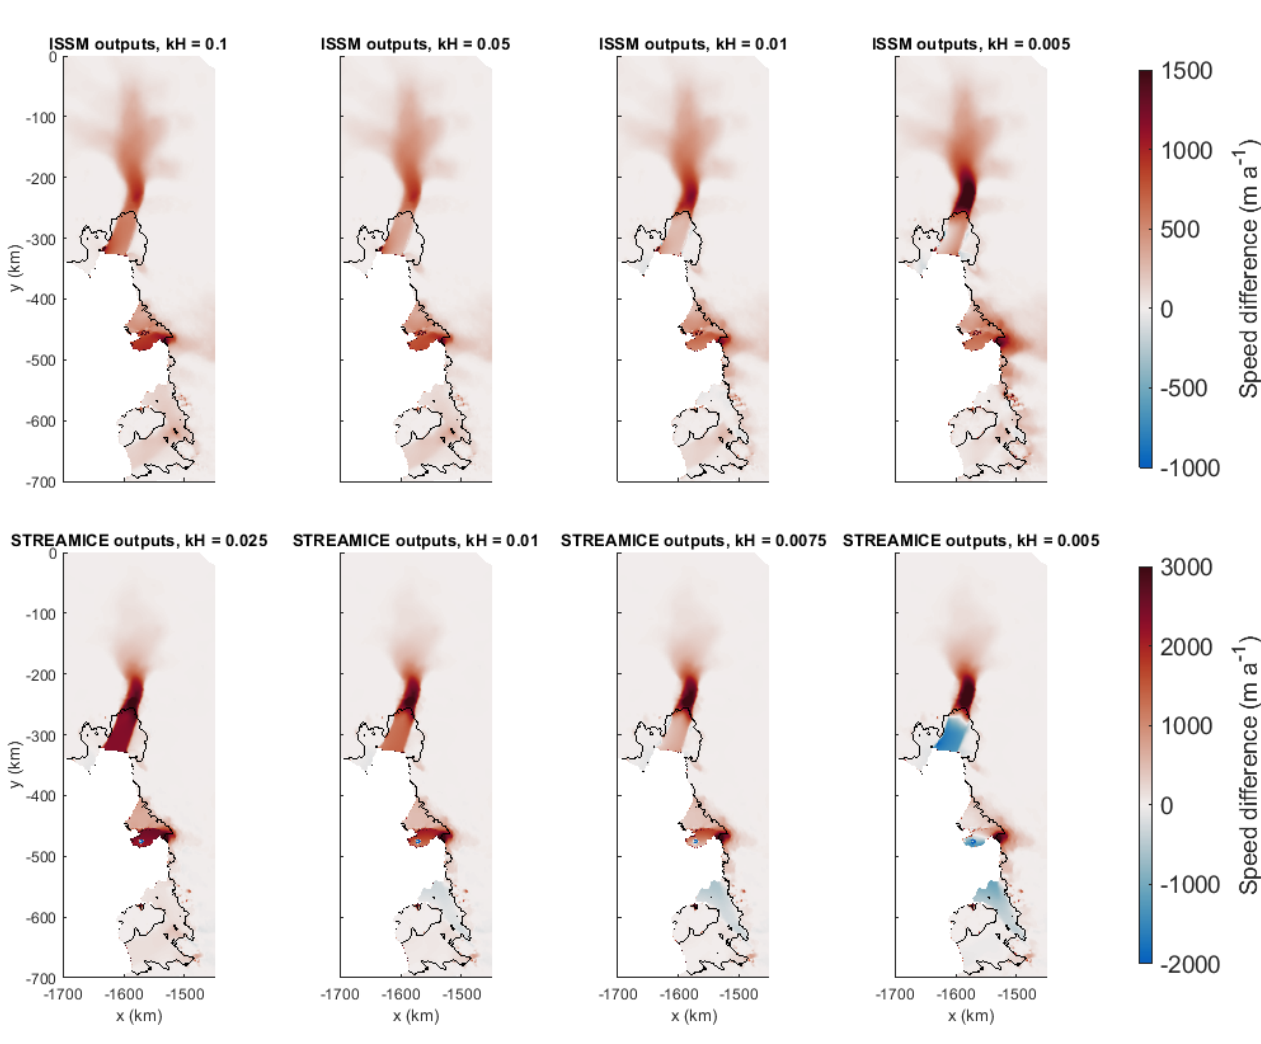
Figure C2. Differences between diagnostic speeds calculated in Úa using the ISSM and STREAMICE inversion outputs and a range of values for kH and the speeds calculated in the original models. Note that each row uses a different colour scale.